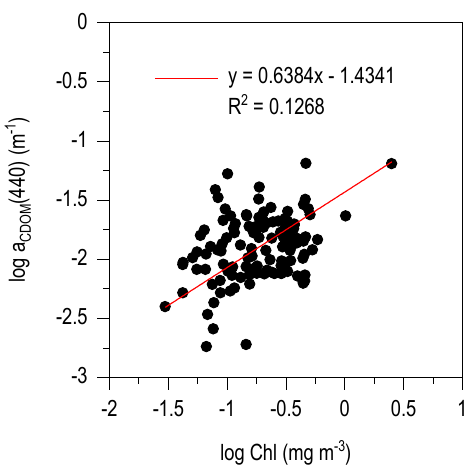
Figure 6. Relationship between a CDOM (440) (m − 1 ) and Chl (mg m − 3 ).